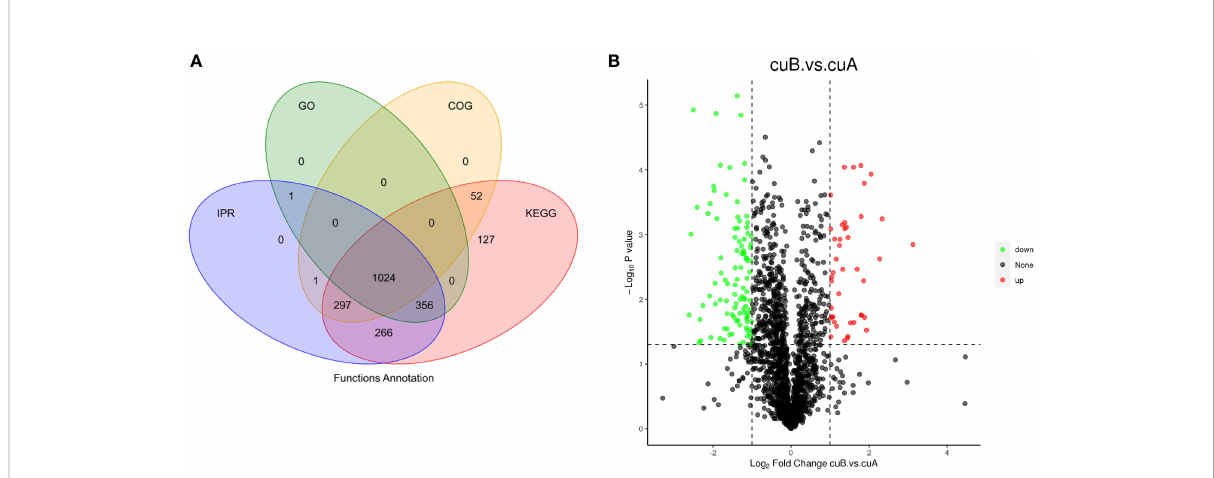
FIGURE 2 Annotation results and expression pro fi les of differentially expressed (DEPs) proteins. (A) Venn diagram of GO, KEGG, Clusters of Orthologous Groups (COG), Interpro (IPR) database annotation results. (B) Volcano maps representing expression pattern of DEGs. Red spots represent upregulated DEGs. Green spots indicate downregulated DEGs. Those shown in black are proteins that did not show obvious changes in A phase and B phase of F hirta bracts. CuA VS CuB represent multiples of protein expression in both A phase and B phase of F hirta bracts.